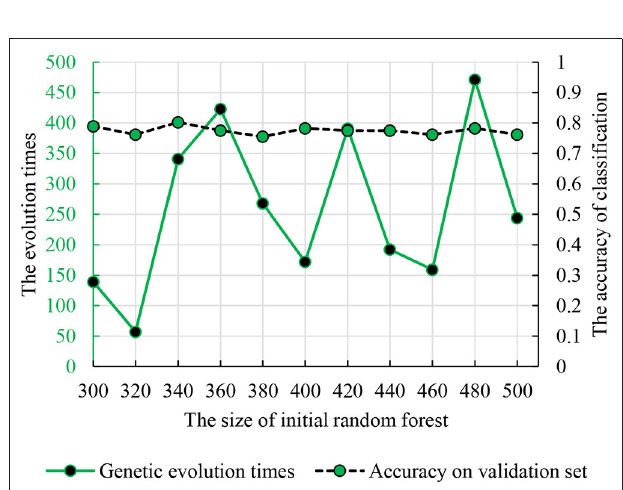
FIGURE 6 | The relationship between the genetic evolution times and initial random forest number. The dotted line is the classification accuracy. The solid line is the times of genetic evolution times based on the decision trees.